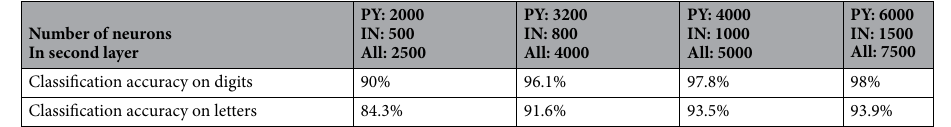
Table 3. Comparison of classification accuracy in dataset MNIST by varying the number of neurons in the second layer.